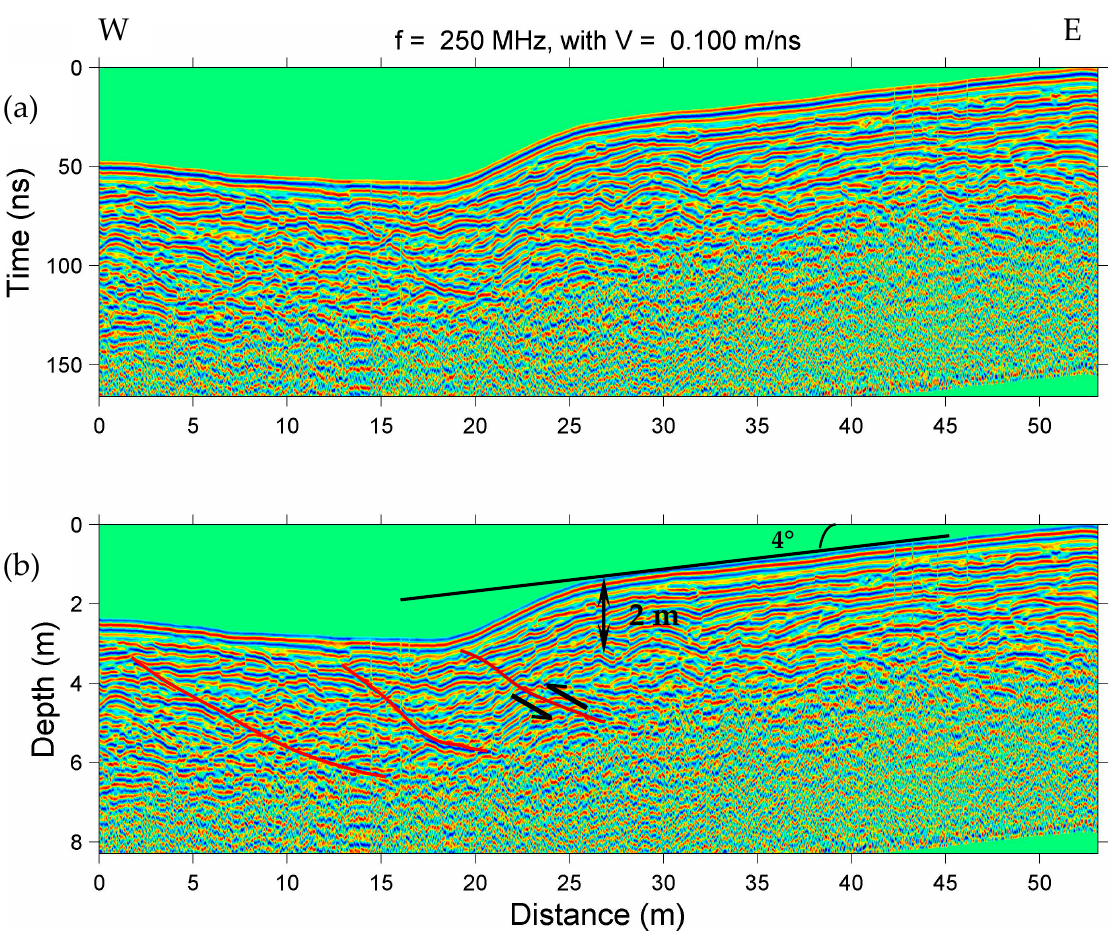
Figure 3. Result of GPR image of the profile 7 acquired in August 2017 with a 250 MHz antenna in the northwestern part of the Songino fault (blue arrow in Figure 2). ( a ) GPR image in time scale; the topographic correction is performed using a velocity of 0.1 m/ns. ( b ) Interpretation of the GPR image converted in depth, showing the thrust fault structure indicated by black arrows. The apparent scarp is about 2 m and the uphill slope is 4°. Red lines show compressive structures.